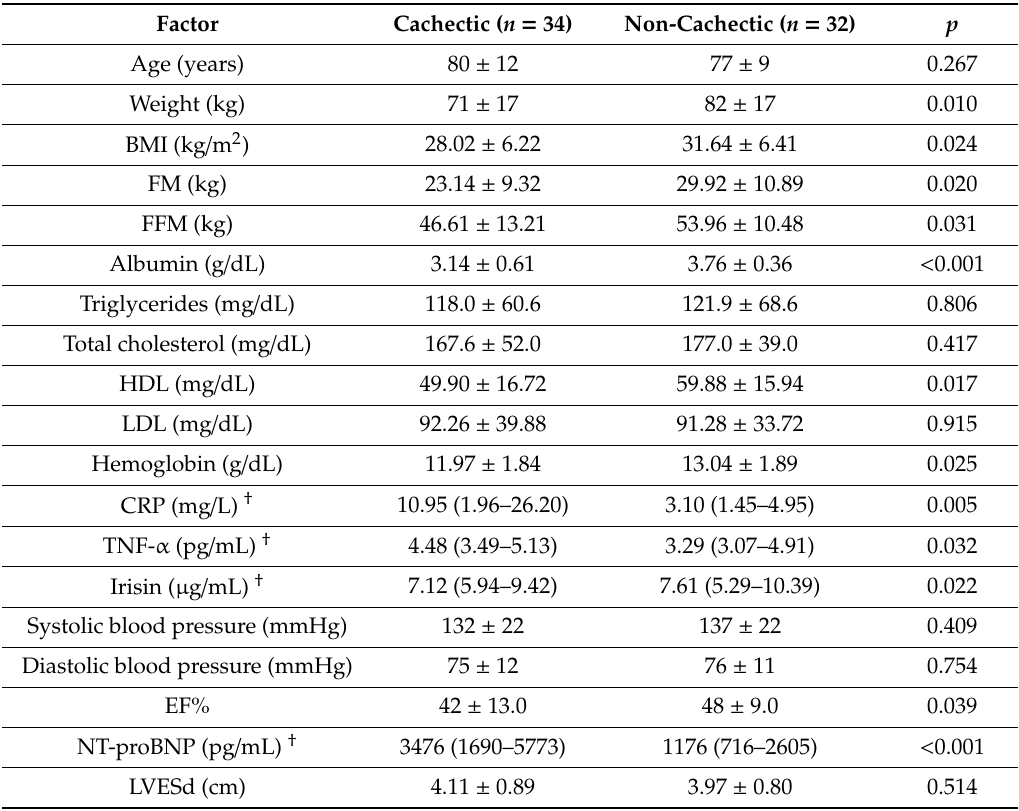
Table 2. Di ff erences in anthropometric, metabolic, inflammatory, nutritional and cardiac parameters between chronic heart failure (CHF) patients with either presence or absence of cachexia (ACEi—Angiotensin-converting-enzyme inhibitors; ARBs—angiotensin receptor blockers; BMI—body mass index; Cm—capacitance of membrane; EF—ejection fraction; FM—fat mass; FFM—fat-free mass; HRT—Hormone replacement therapy; LAD—left anterior descending artery; LVEDd—left ventricular end-diastolic diameter; LVESd—left ventricular end-systolic diameter; NYHA—New York Heart Association; Pa—phase angle (50kHz); PASP—pulmonary artery systolic pressure;